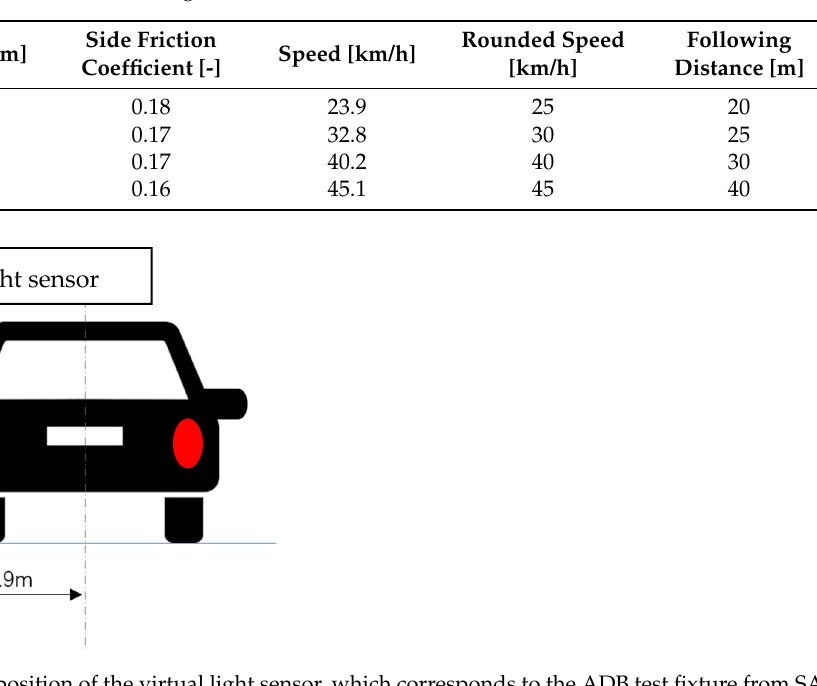
Table 1. Parameters of the driving scenario.